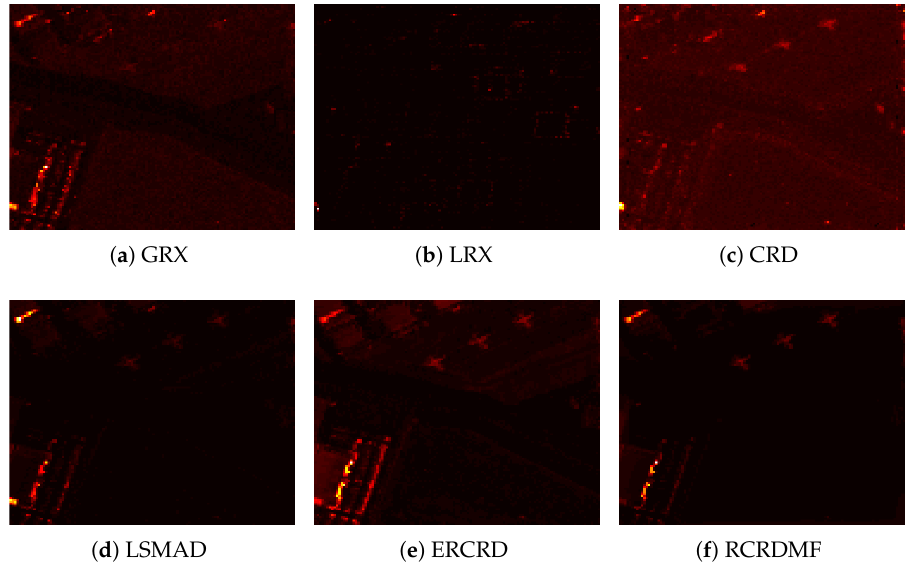
Figure 5. Color detection maps obtained by different algorithms for the AVIRIS-I dataset. ( a ) global RX (GRX), ( b ) local RX (LRX), ( c ) CRD, ( d ) LRaSMD-based Mahalanobis distance method (LSMAD),